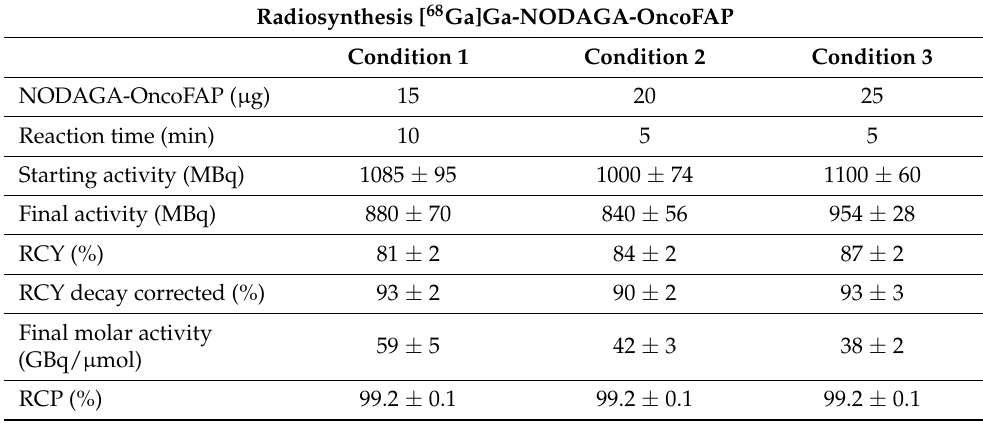
Table 2. Different synthetic conditions used for [ 68 Ga]Ga-NODAGA-OncoFAP.